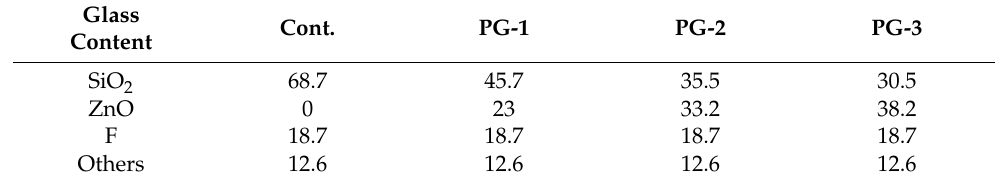
Table 3. Prospective compositions of Cont, PG-1, PG-2, and PG-3 glasses (mol%) during